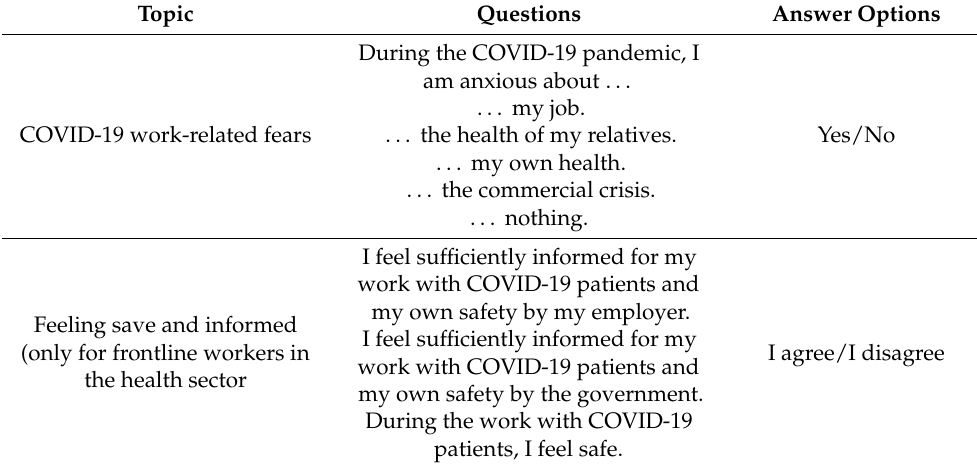
Table 1. COVID-19-related